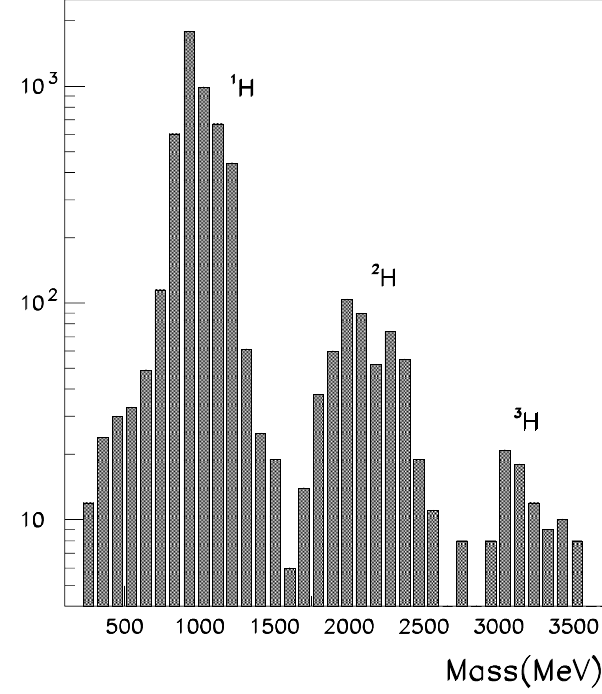
Fig. 1. Mass distribution of particles with charge Z = 1 at L- shell < 3 and B > 0 . 26G, as measured by